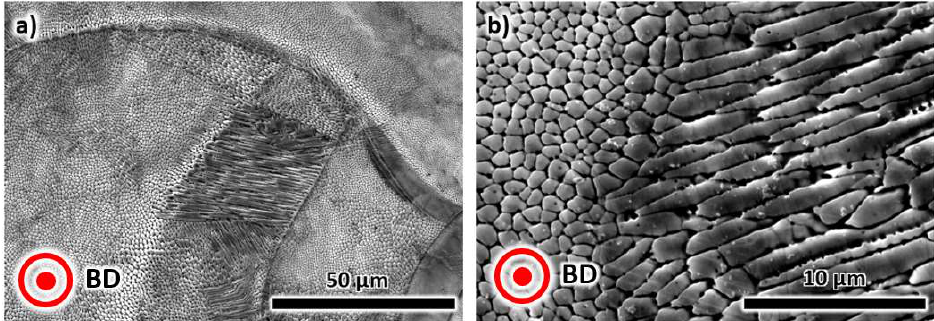
Figure 3. Scanning electron microscopy images of the as-printed 316L sample taken from the plane normal to the building direction (BD) at ( a ) a lower magnification, and ( b ) at a higher magnification.